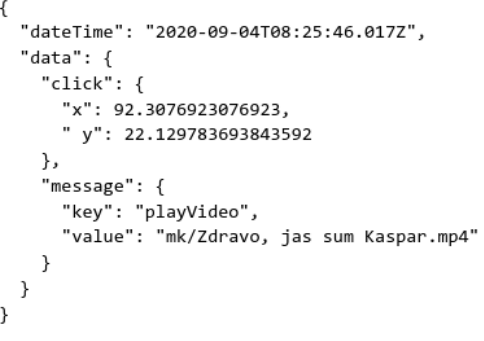
Figure 8. Example of one log.